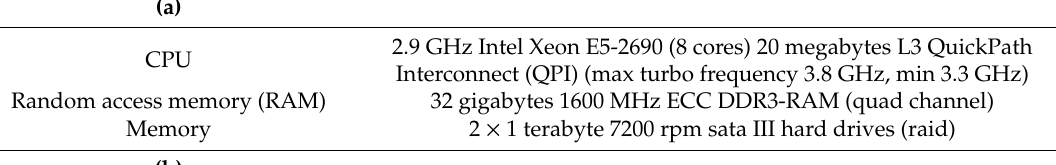
Table 2. ( a ) Computing system. ( b ) Model-related computation time. (a)